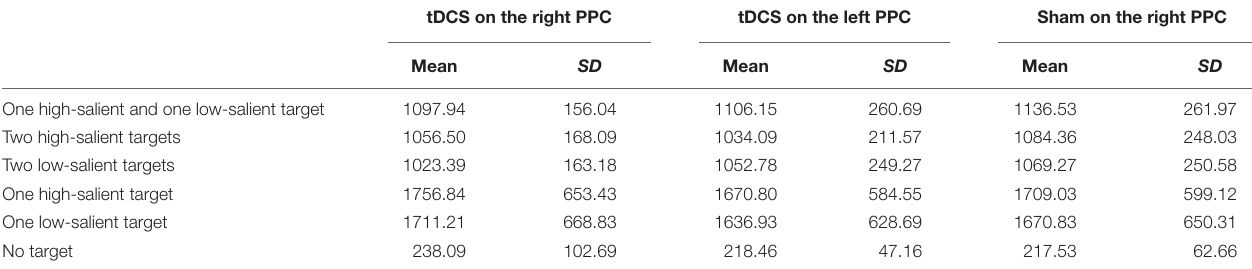
TABLE 4 | Means and standard deviations (SD) in reaction time (ms) of the second mouse click for different stimulation conditions. tDCS on the right PPC tDCS on the left PPC Sham on the right